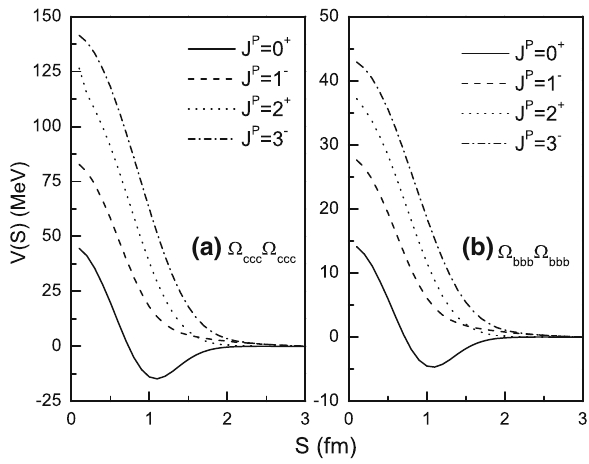
Fig. 1 The effective potential of the Ω ccc Ω ccc and Ω bbb Ω bbb systems